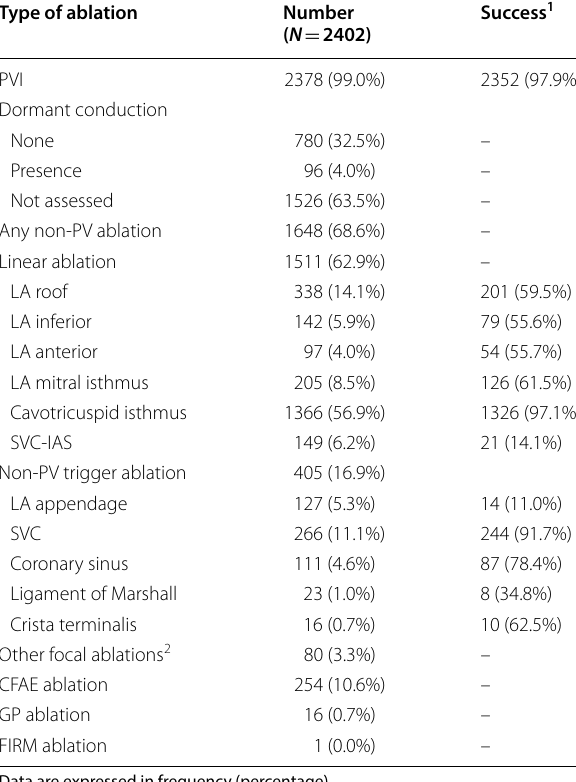
Table 3 Acute procedural acute success rate in various types of ablation